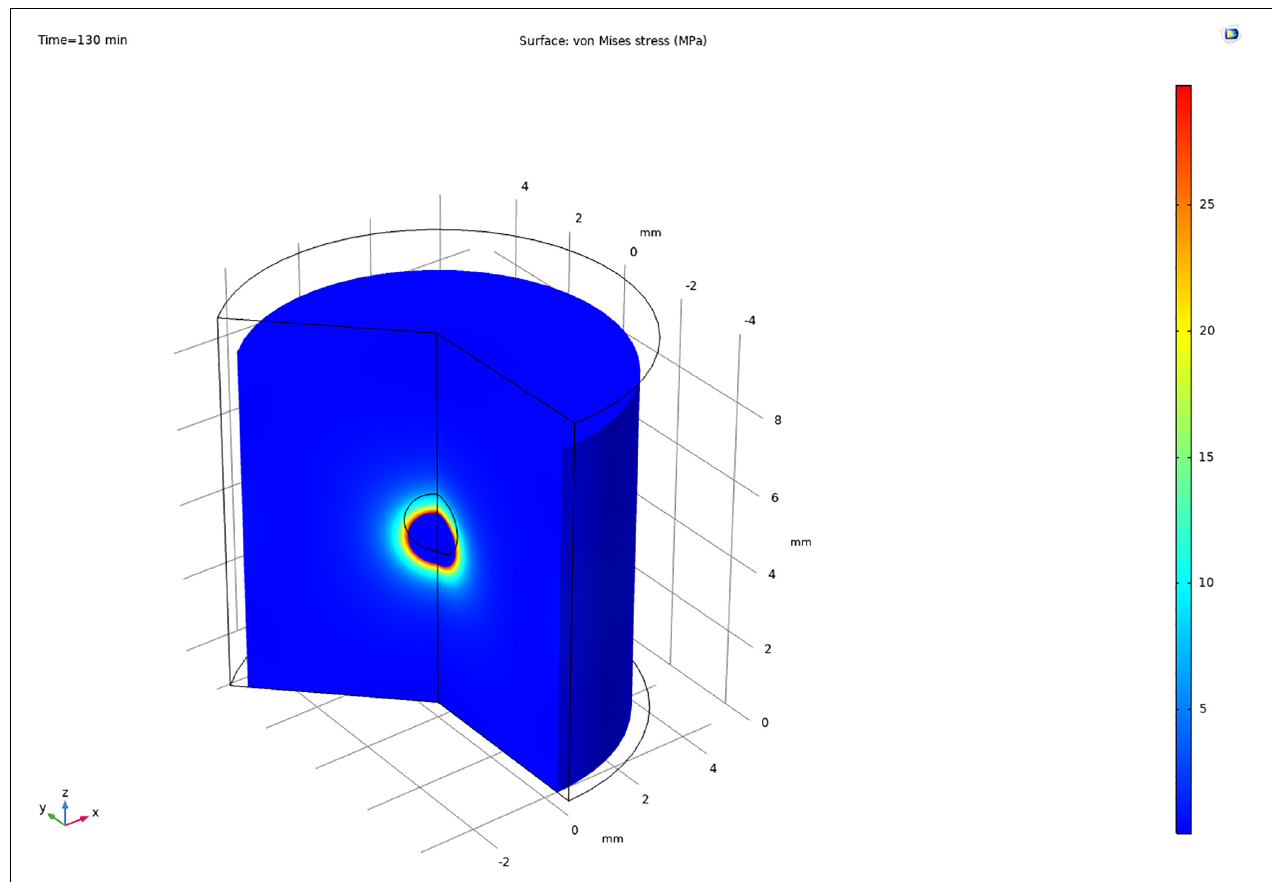
FIGURE 10 | Stress distribution in UO 2 pellet containing a lumped Gd 2 O 3 sphere ( r = 0.75